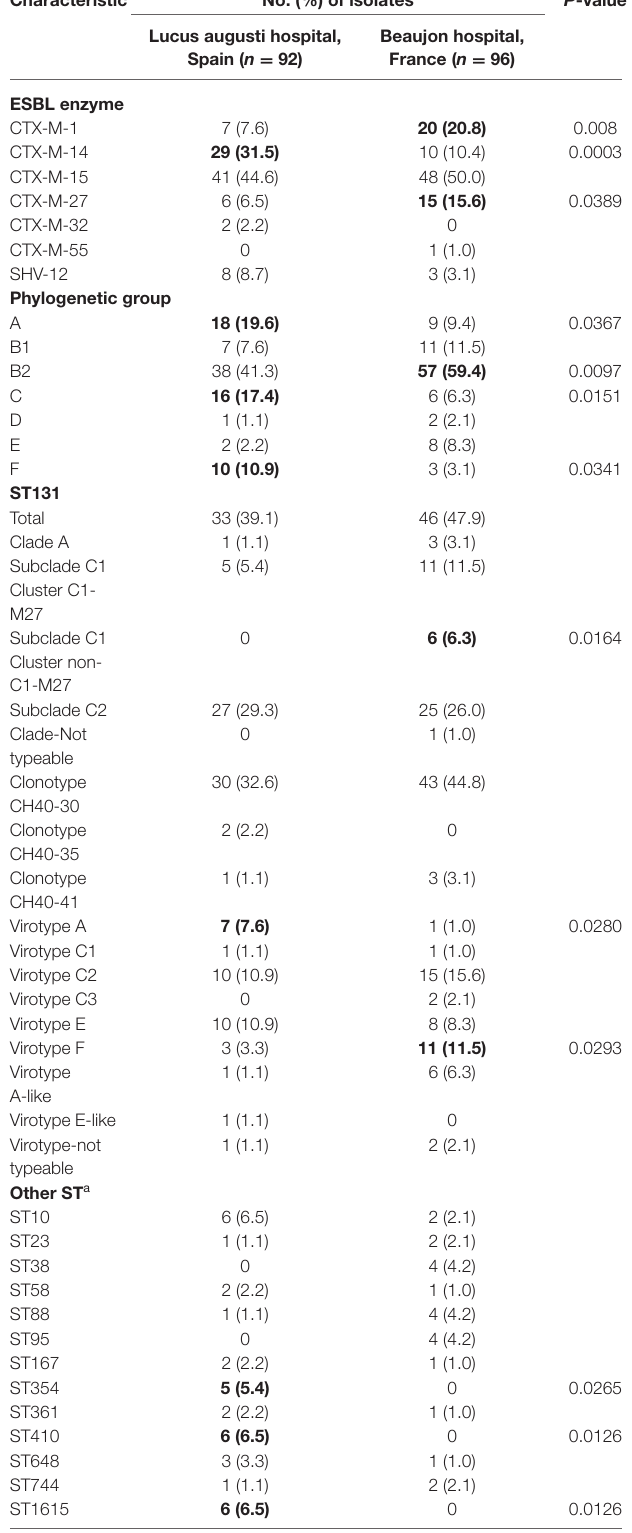
TABLE 1 | Characteristics of 188 ESBL-EC isolated from extraintestinal